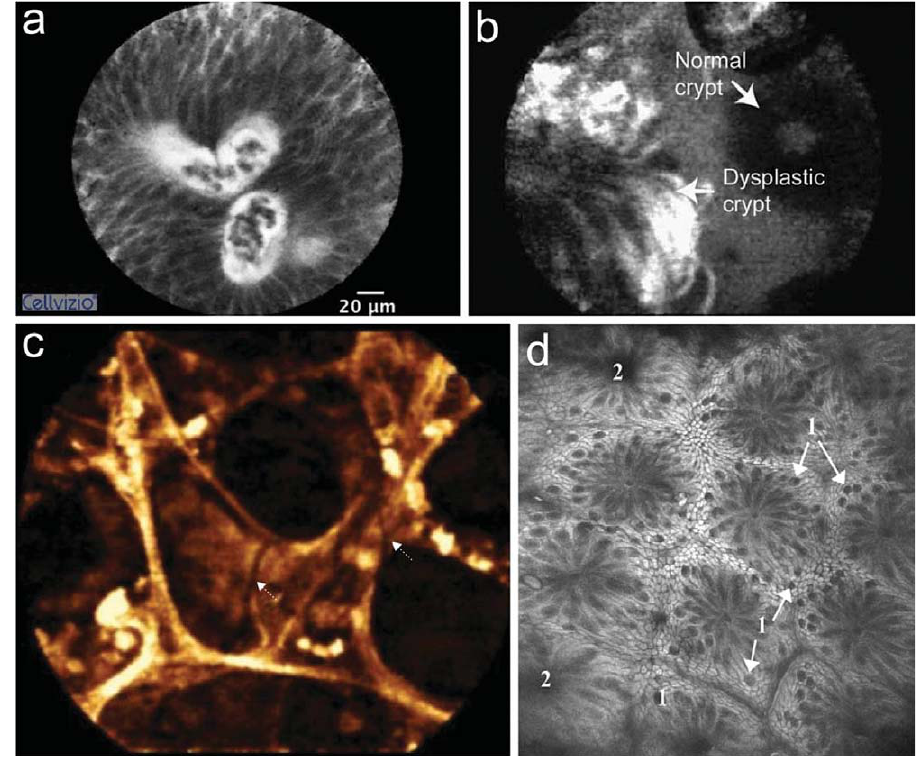
Fig. 3. a: Endomicroscopic image of a low-grade papillary tumor in a human bladder taken with a fibered confocal microscope (Mauna Kea Technologies)consistingofa2.6mmdiameterflexibleprobe.Laserilluminationwastransmittedthroughanimagingbundleofmorethan30,000 optical fibers. The image was taken at a depth of 60 (cid:1) m with a 240- (cid:1) m diameter FOV. Scale bar indicates 20 (cid:1) m [113]. b: In vivo confocal fluorescence image of the border between colonic adenoma and normal mucosa, showing peptide binding to dysplastic colonocytes. Image taken in a human patient with the Cellvizio-GI imaging system by Mauna Kea Technologies, based on a fiber-bundle design [114]. c: Fibered confocal fluorescence microscopy imaging of the alveoli in the lungs of a smoker during bronchoscopy. A 1.4-mm diameter Cellvizio-Lung prototype was used (Mauna Kea Technologies), based on a fiber-bundle design. The field of view is 600 (cid:1) m in diameter. Scale bar represents 50 (cid:1) m [115]. d: Confocal image of the subsurface microvasculature of normal, descending human colon, collected in vivo following intravenous injection of sodium fluorescein. The confocal microscope, developed jointly by Pentax and Optiscan, is permanently integrated into an endoscope and utilizes a single fiber that is mechanically scanned with piezoelectrics. FOV=500 × 500 microns